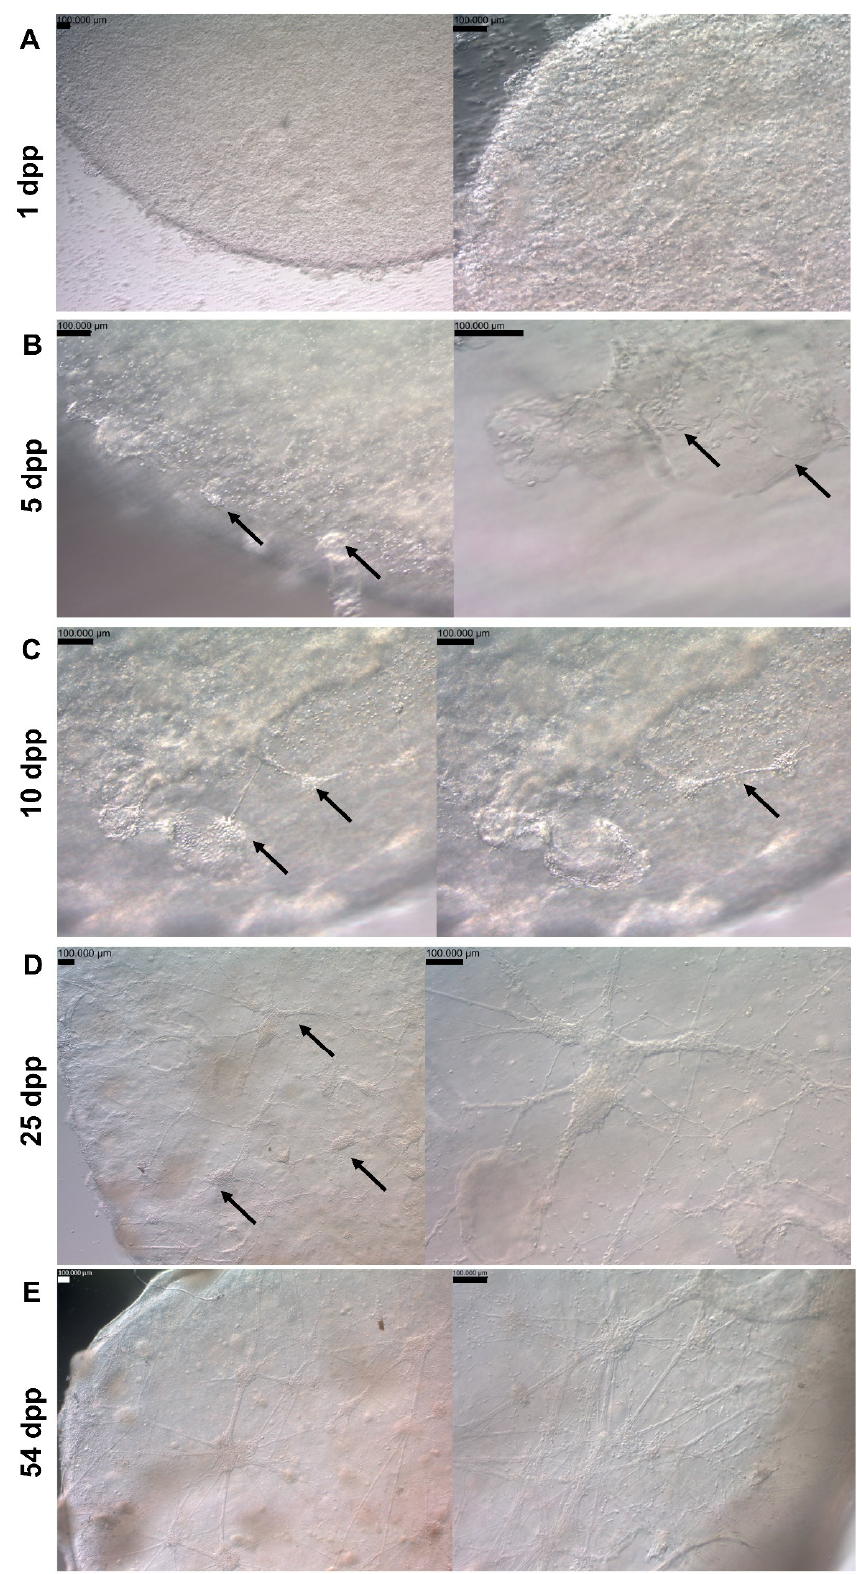
Figure 5. Bioprinted hNPCs’ change of morphology over time. Light microscope images of 3D-bioprinted hNPCs in neural maturation media 1 dpp ( A ). Light microscope image of 3D-bioprinted hNPCs in neural maturation media 5 dpp. Cells present a more NPC-like morphology (arrows) and